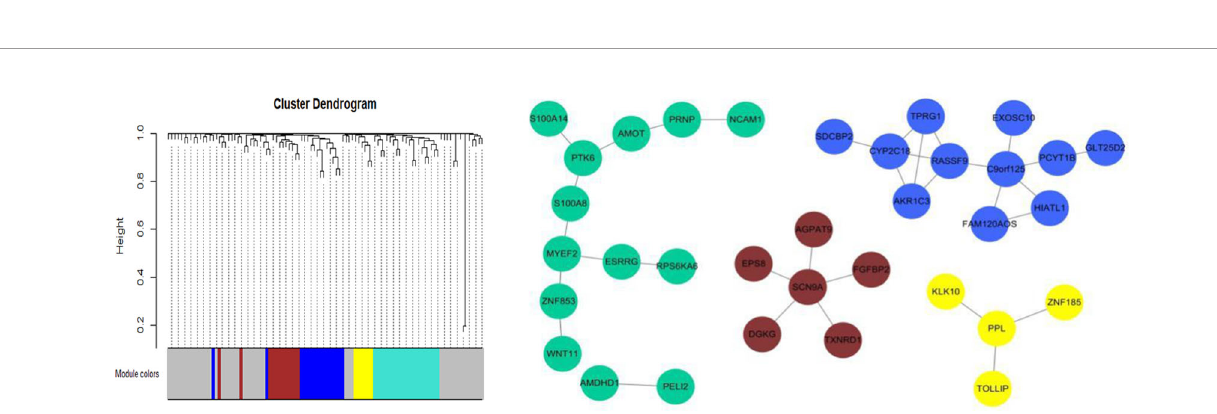
FIGURE 8 | Weighted gene coexpression network analysis (WGCNA) for the top 100 nonlinearly expressed genes in the lung squamous cell carcinoma (LUSC) dataset. Power is set to 5 and the threshold of TOM is set to 0.05.